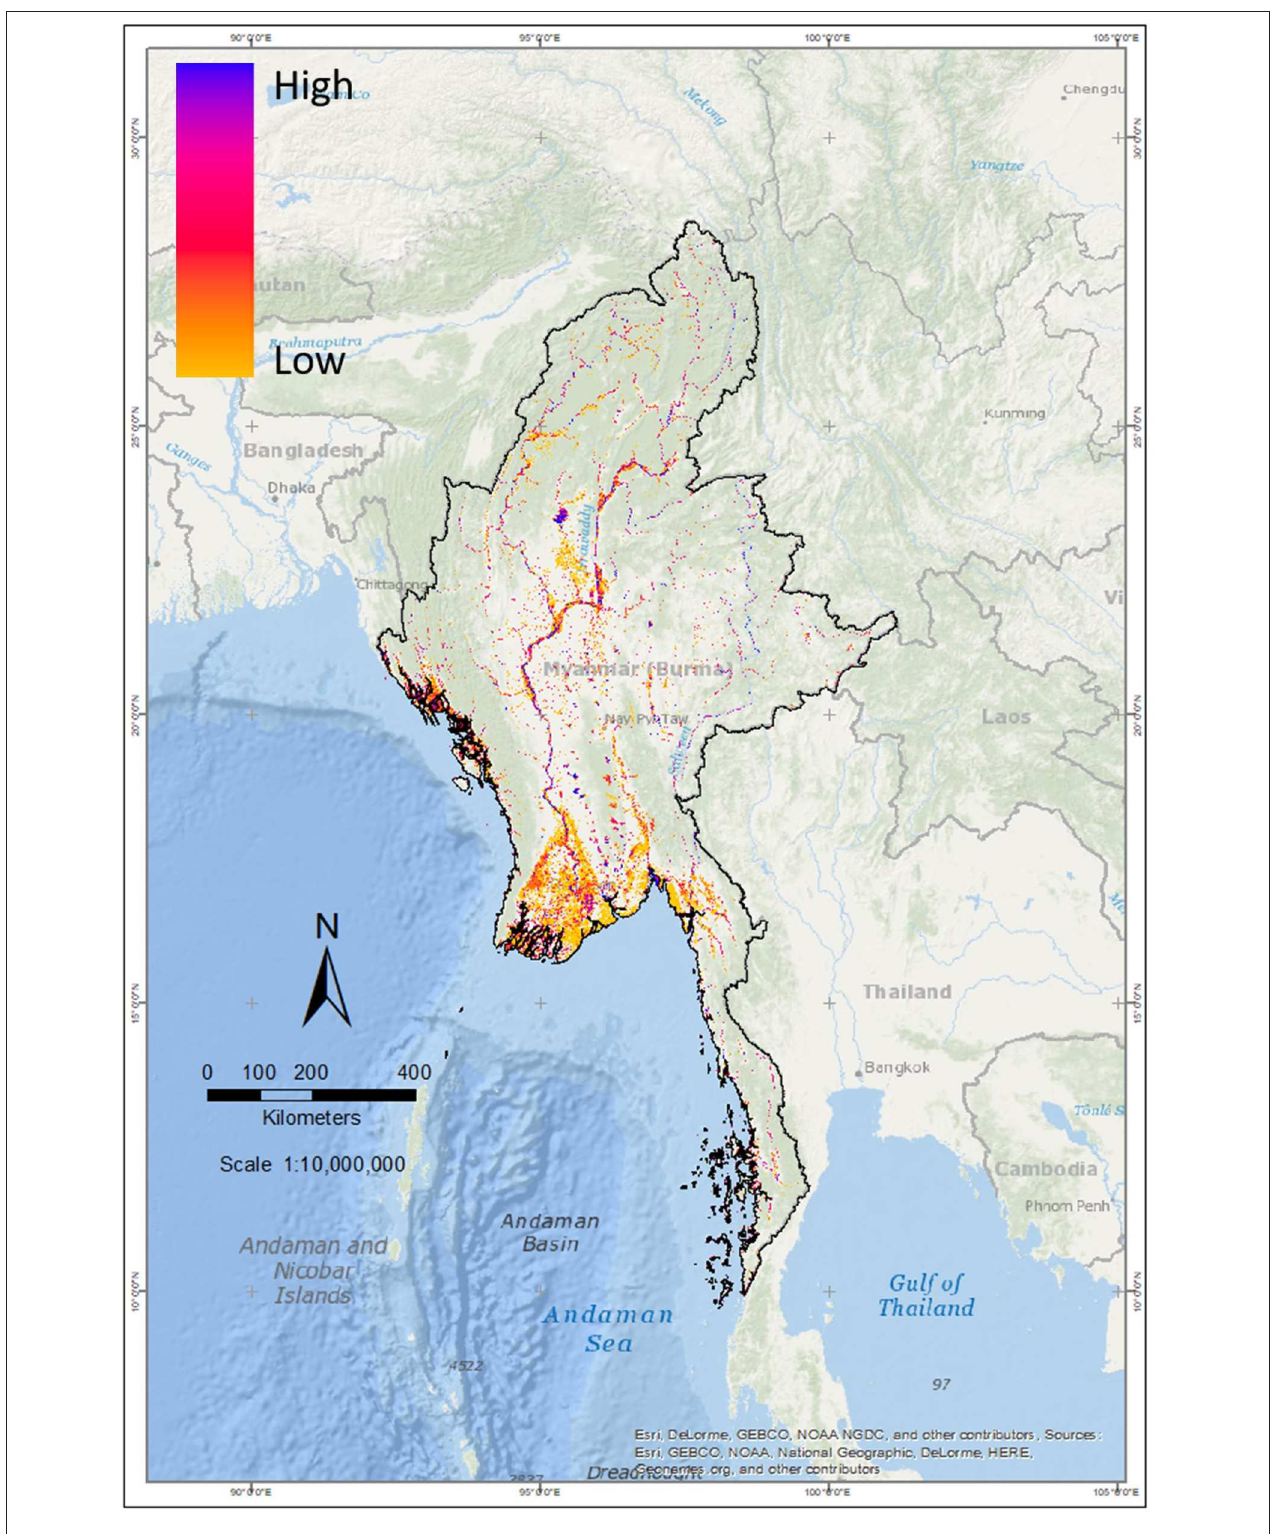
FIGURE 5 | Flood frequency map of Myanmar calculated from the JRC surface water data.